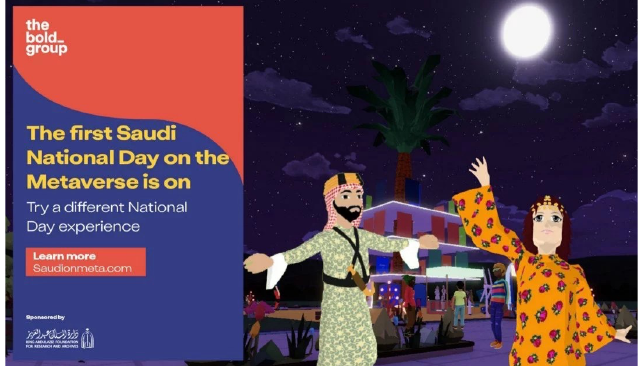
Figure 7: Saudi Arabia’s National Day in the metaverse During the period of UK’s national mourning following the death of Her Majesty the Queen, a tribute was paid to her at